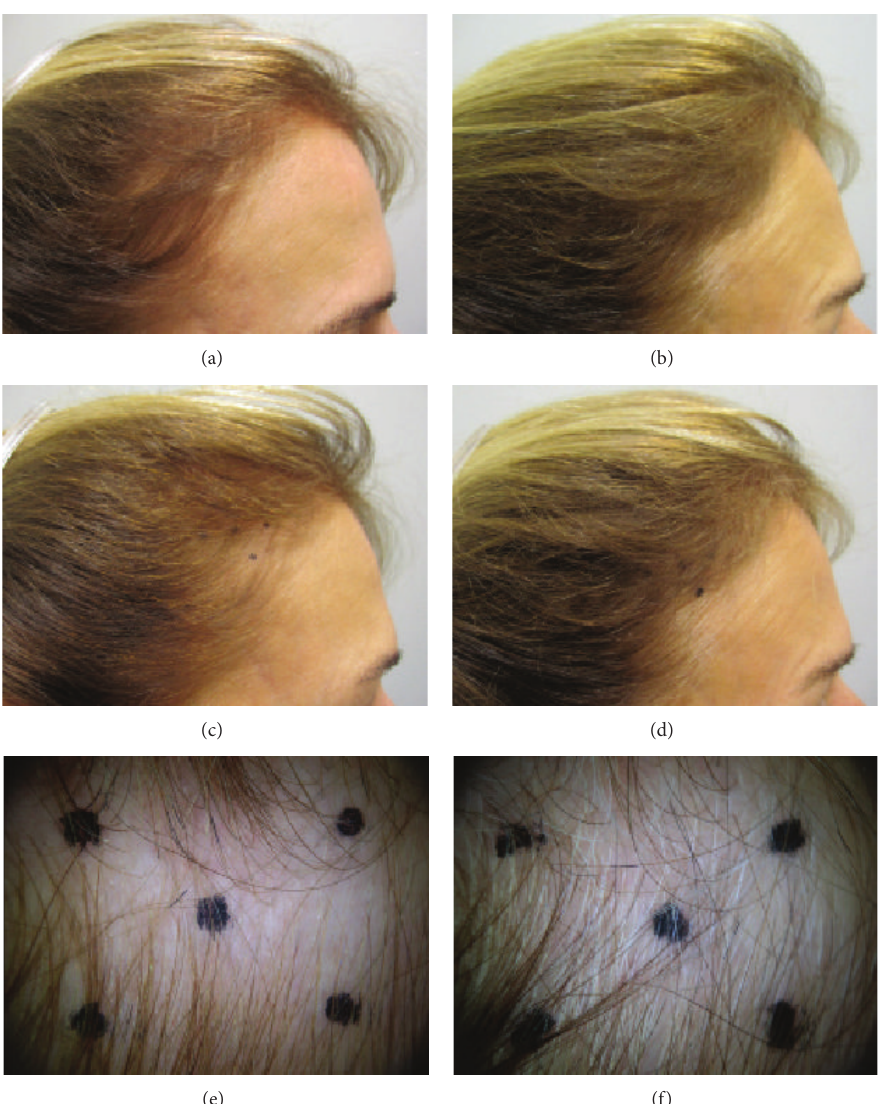
Figure 2: Subject 47. The number of terminal and vellus hairs at baseline (left) increased significantly after 90 days of treatment (right). The 4 cm 2 target area of the scalp is shown in the middle and bottom